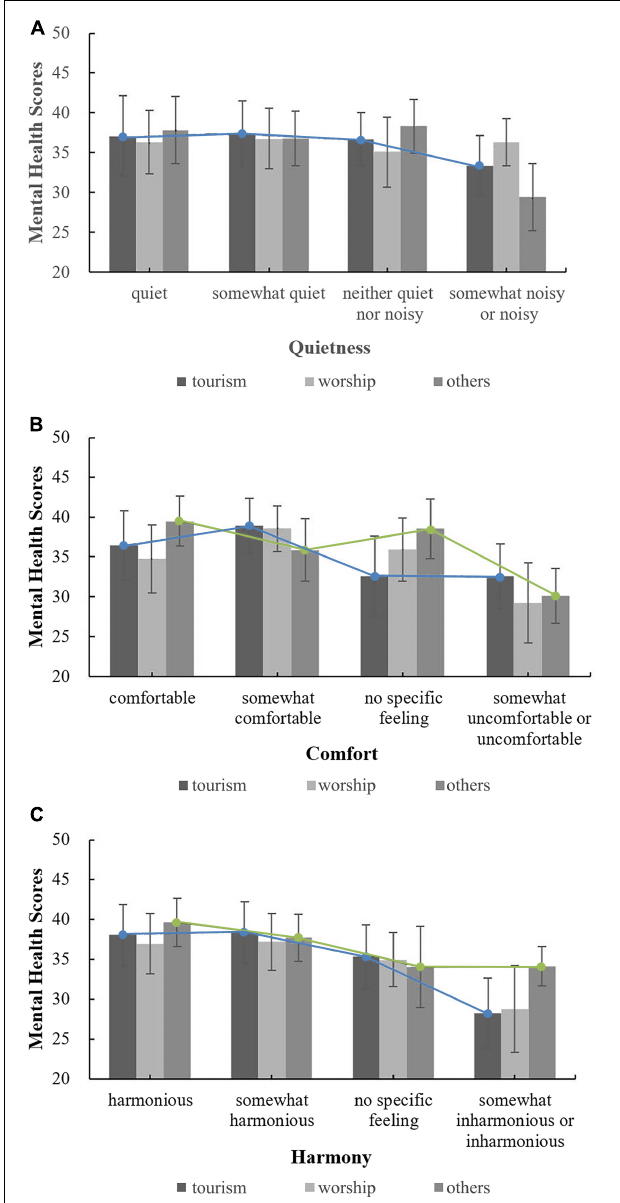
FIGURE 6 | The relationships between the evaluations of the overall acoustic environment and mental health by purpose of visiting. (A) Quietness; (B) Comfort; (C)